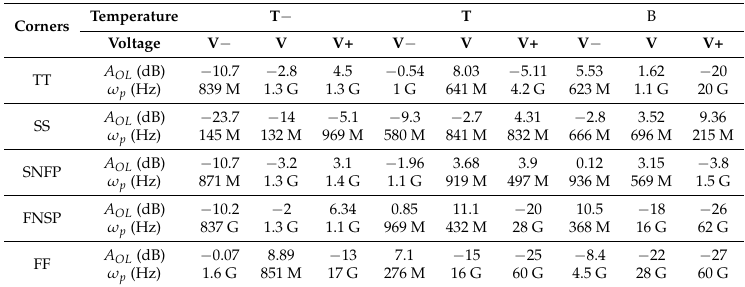
Table 6. Post-layout open-loop gain and dominant pole frequency values under PVT variations and setting V ctrl = − 0.2 V.